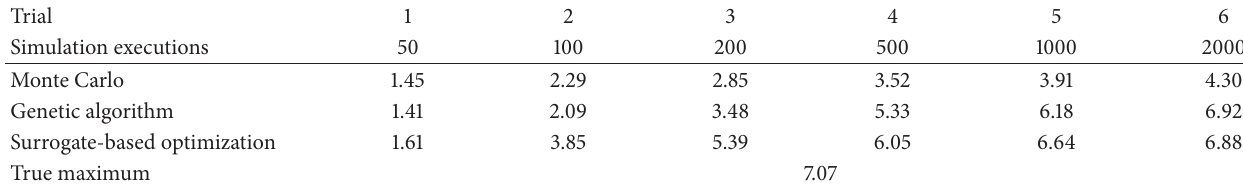
Table 4: Mean lateral deviation (in meters) for the 50 most challenging test cases generated.